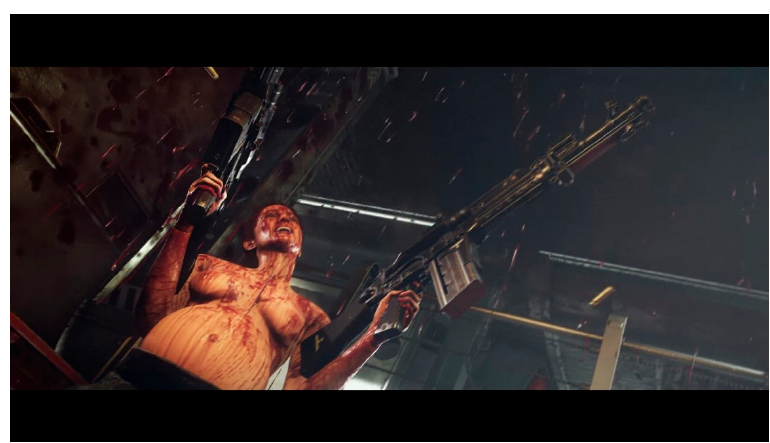
Figure 6. Anya as the carnivalesque female, birthing death.